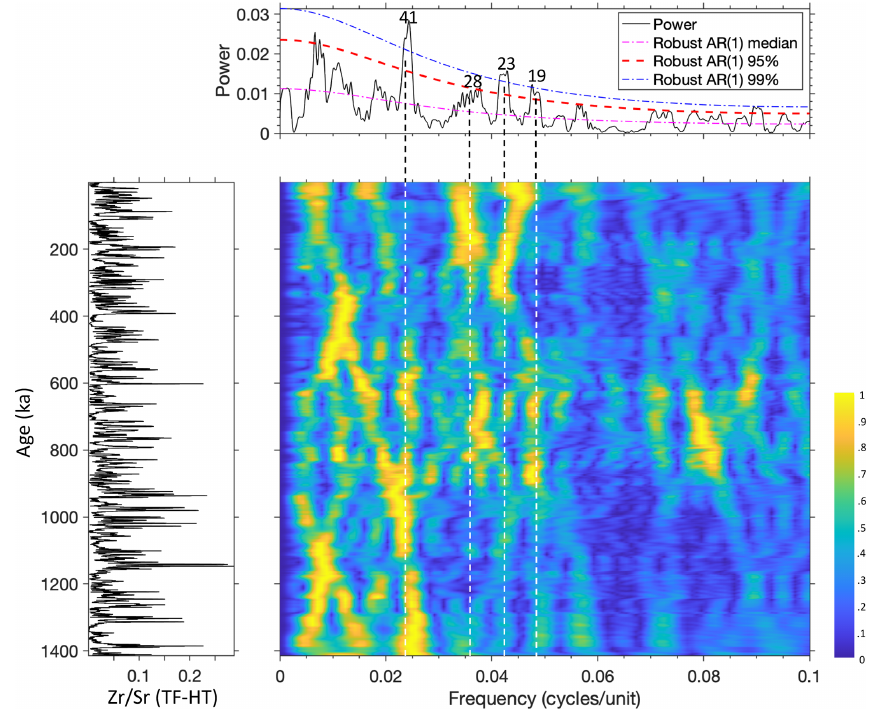
Figure 16. Same as Fig. 15 but for Zr–Sr.